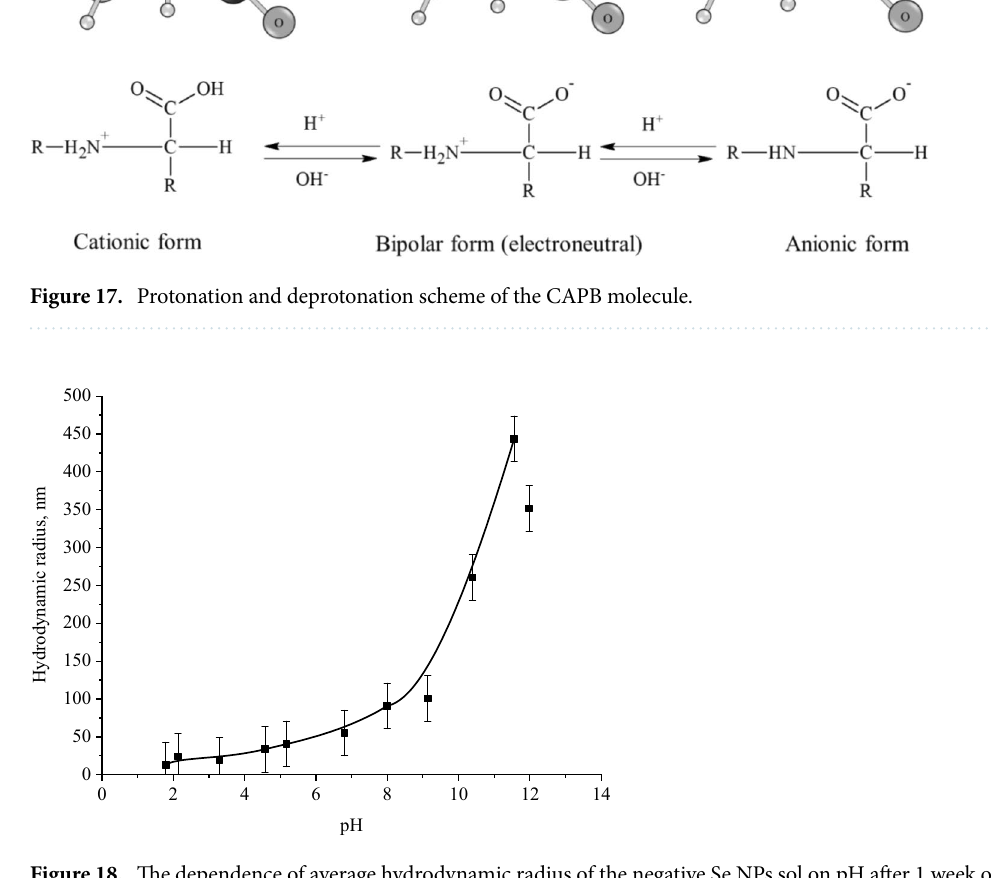
Figure 18. The dependence of average hydrodynamic radius of the negative Se NPs sol on pH after 1 week of exposure.